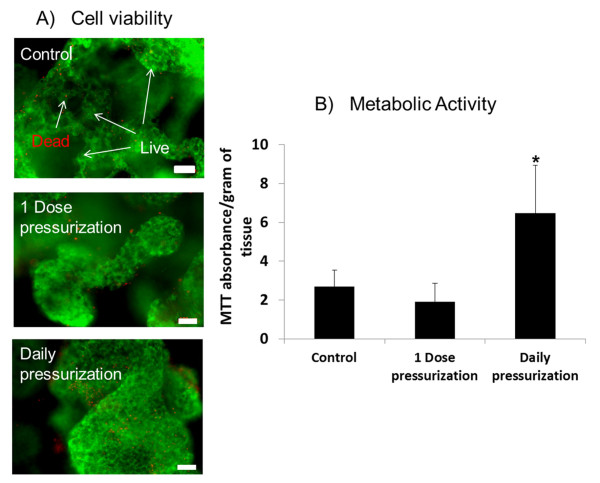
Cell viability and metabolic activity in nucleus pulposus tissue with and without pressurization. (A) Viability was assessed using calcein (green = live) and ethidium (red = dead) staining and showed no differences between groups, with the majority of the cells stained green indicating high viability (images captured on a fluorescent inverted microscope, bar =10 μm). (B) Metabolic activity was significantly increased for the Daily pressurization group (P < 0.05) as assessed by the (4,5-dimethylthiazol-2-yl)-2,5-diphenyltetrazolium bromide (MTT) assay compared with unloaded control and 1 Dose load groups.